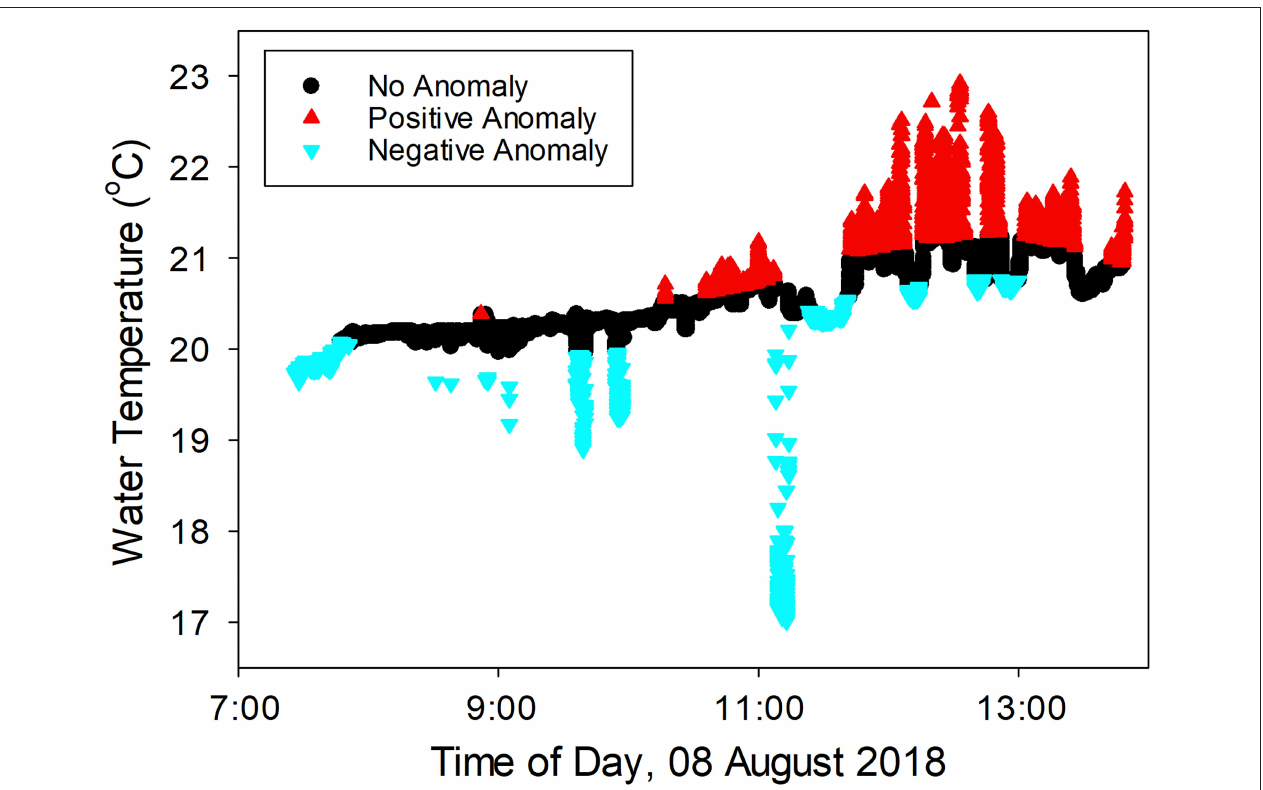
FIGURE 5 | Example of background trends and anomalies from data collected on August 8, 2018. Temperature data is classified by relationship to the background trend identified by the loess model. Measured temperatures outside of this range are either marked as positive or negative anomalies.